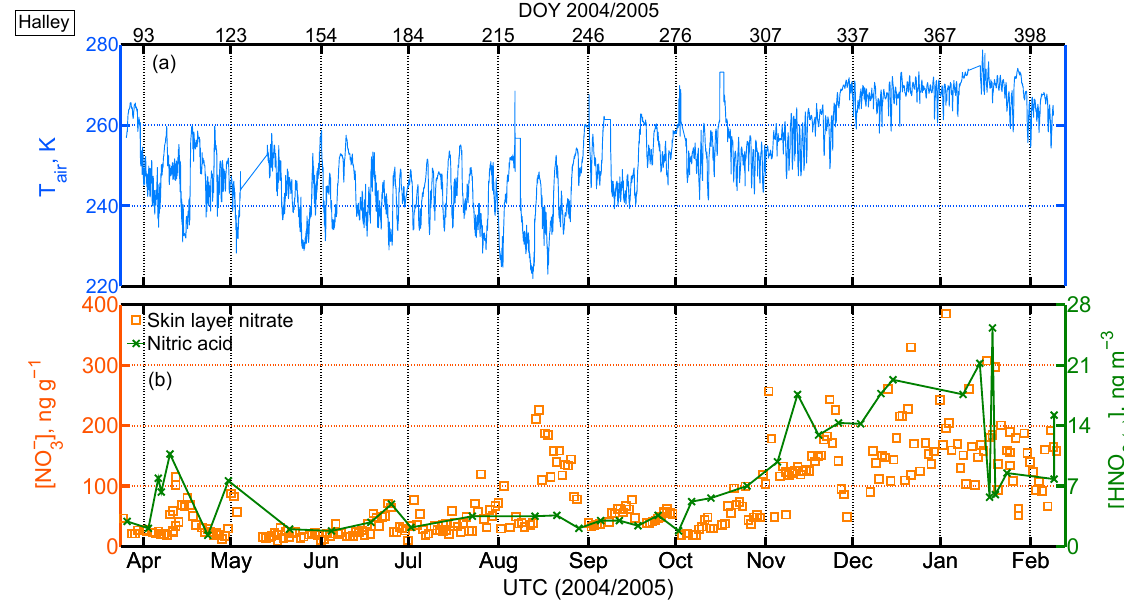
Figure 3. Atmospheric and snow observations from Dome C from Erbland et al. (2013)). (a) Air temperature (blue, left axis) and atmospheric pressure (red, right axis). (b) NO − in the snow skin layer (i.e. top 4 ± 2mm, orange square, left axis) and atmospheric NO − 3 atmospheric particulate NO − and HNO 3 (green, right axis). 3